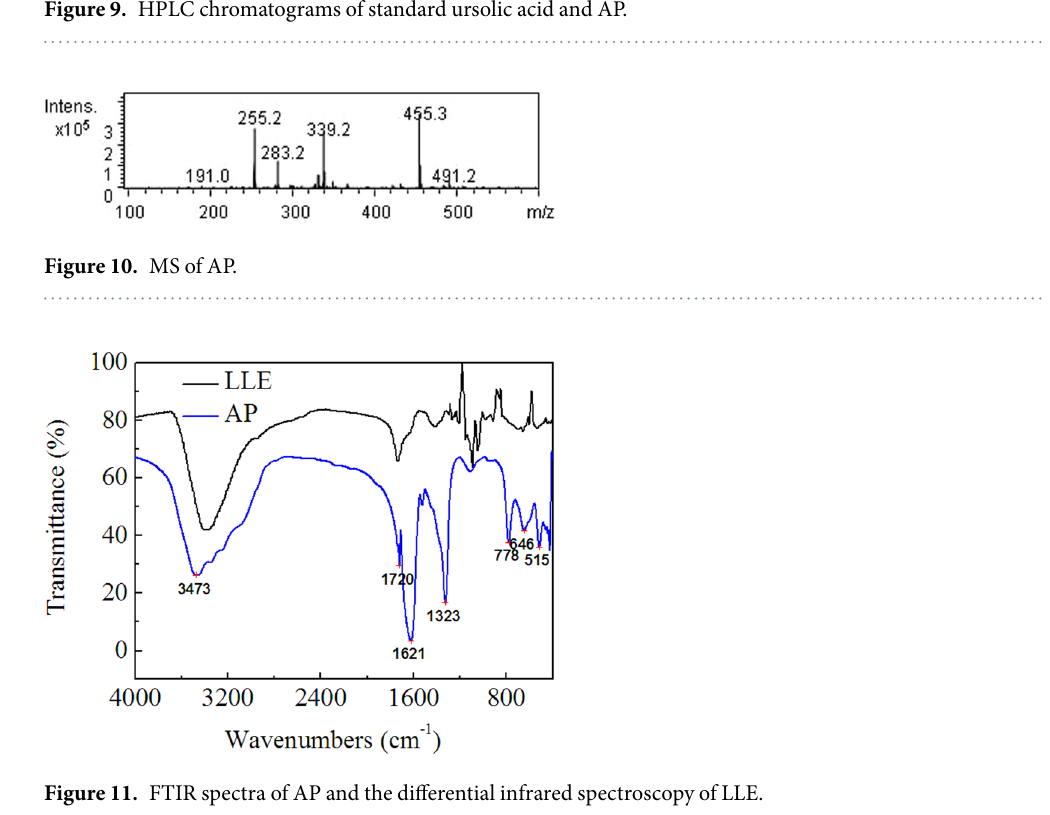
Figure 11. FTIR spectra of AP and the differential infrared spectroscopy of